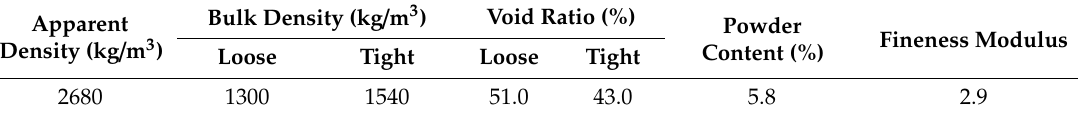
Table 3. The basic performance of manufactured sand.